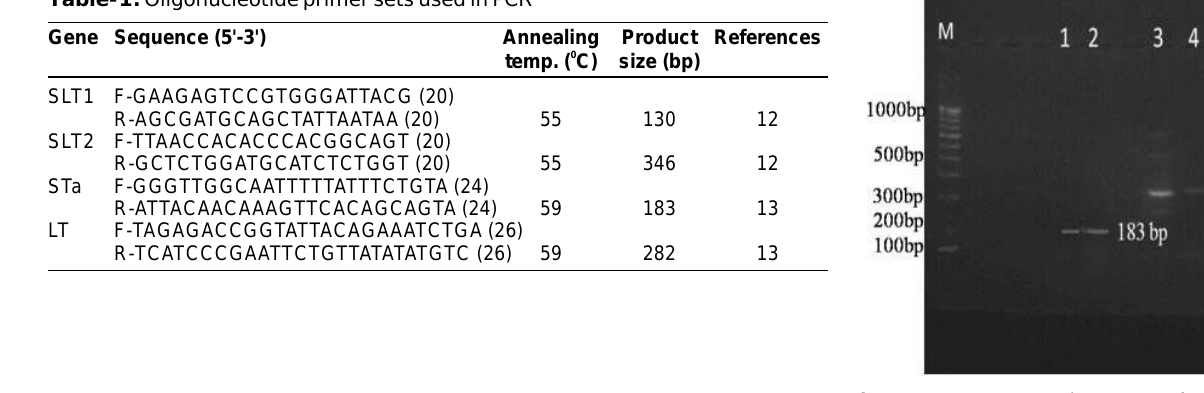
Figure-1. SLT2 gene and STa gene of E. coli Lane M: 100 bp